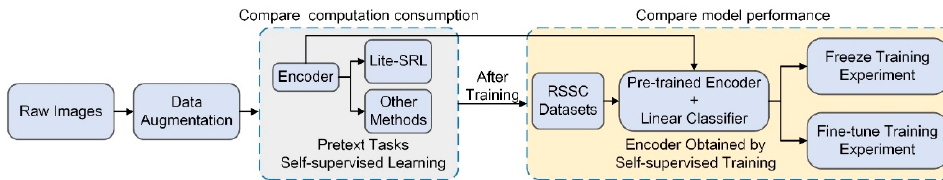
Figure 6. The flowchart of self-supervised learning experiments.